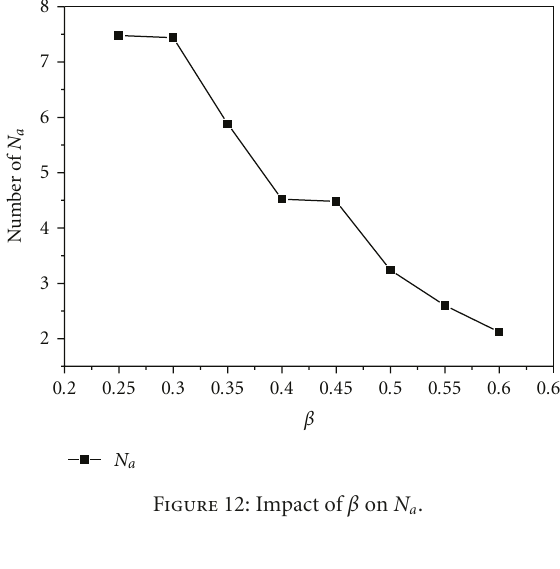
Figure 12: Impact of β on N a .